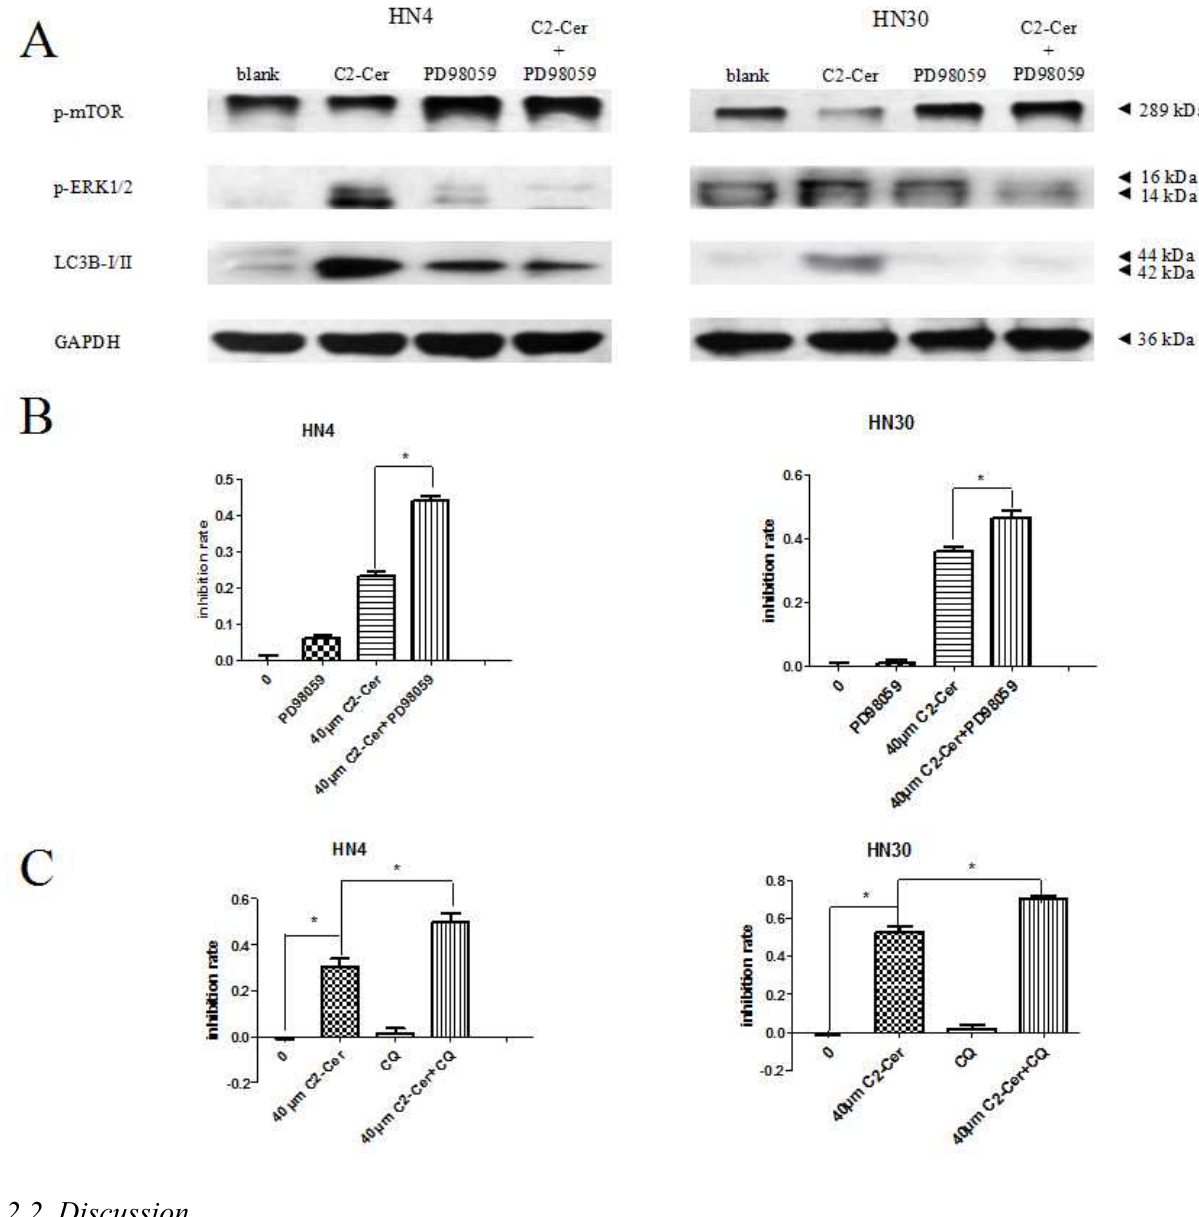
Figure 6. ( A ) Western blotting. Expression levels of LC3B-II, phospho-mammalian target of rapamycin (p-mTOR) and phospho-extracelluar signal-regulated kinase 1/2 (p-ERK1/2) were analyzed after treatment with PD98059/C2-Cer. LC3B-II and p-ERK1/2 levels declined and p-mTOR levels were elevated compared with cells treated with C2-Cer only; ( B ) CCK8 assay. Treatment with 10 μ M PD98059 significantly reduced the viability of cells exposed to C2-Cer; ( C ) CCK8 assay. CQ enhanced the growth-inhibition effect of C2-Cer compared with C2-Cer only. ( * : p <